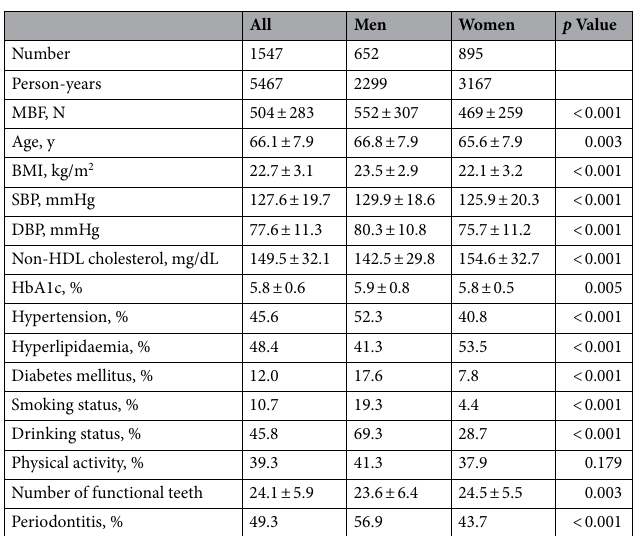
Table 1. Subjects’ baseline characteristics. Data are frequencies or means ± SD. MBF, maximum bite force; BMI, body mass index; SBP, systolic pressure; DBP, diastolic blood pressure; HDL, high-density lipoprotein- cholesterol; Physical activity, ≥ 60 min walking per day. Analysis of variance was used for comparisons of multiple group means, and the Chi-squared test was used to compare frequencies.